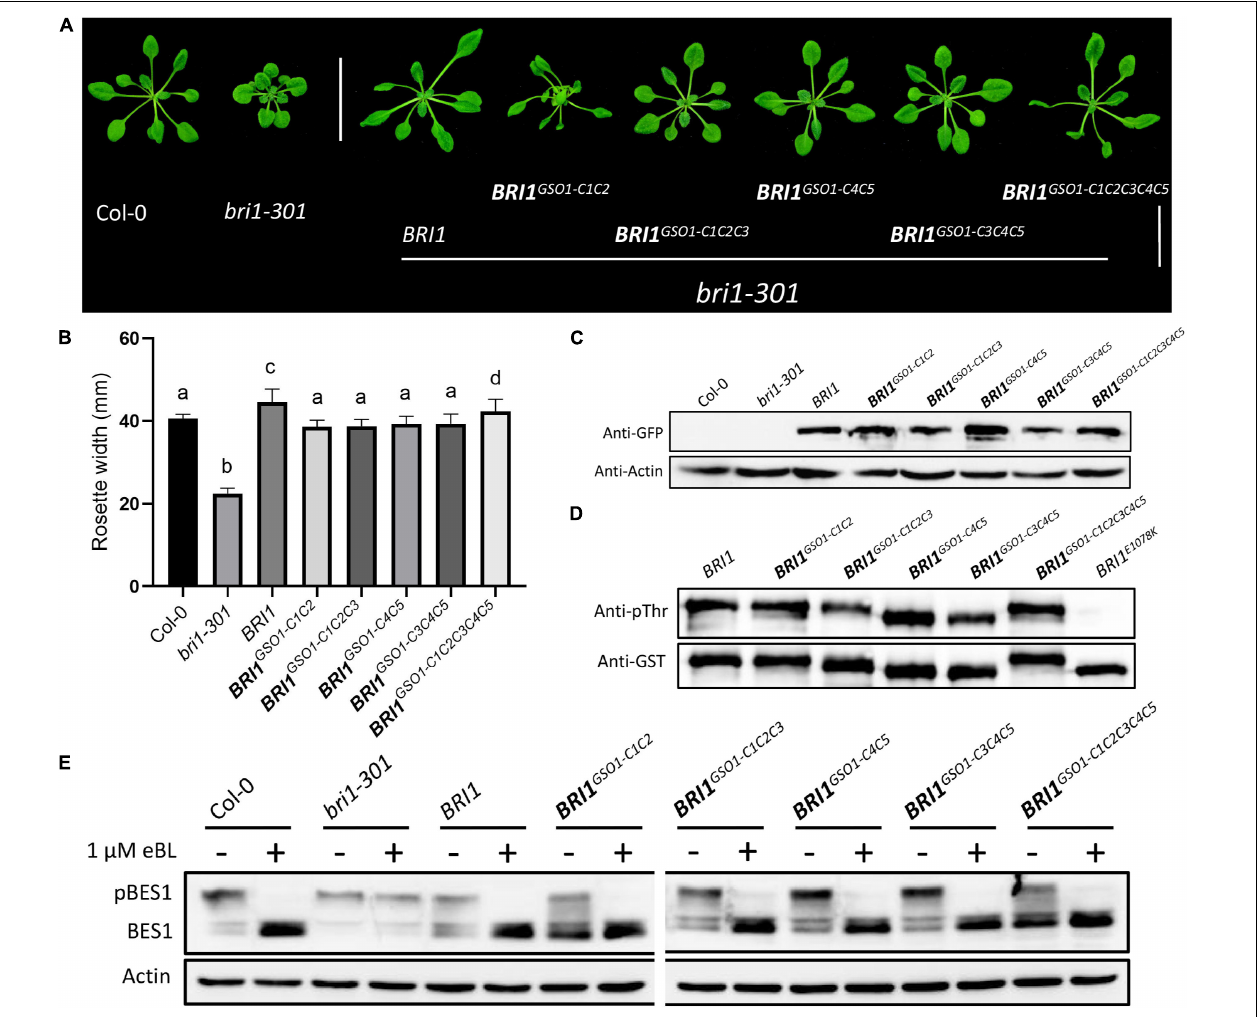
FIGURE 3 | Functional conservation in the C domains of BRI1. (A) phenotypes of 4-week-old transgenic lines representing the expression of functionally conserved chimeric receptors. Scale bar = 2.0cm. (B) Measurement of rosette width of transgenic lines ( n = 15), p < 0.0001, one-way ANOVA with a Tukey’s test. (C) Transgenic lines depicting protein expression profile. Anti-GFP was used to quantify the protein and actin served as a loading control. (D) In vitro kinase assay of GST-fused BRI1 and its chimeric proteins using an anti-pThr antibody. Anti-GST antibodies served as a loading control. Kinase-null mutant BRI1 E1078K was used as a negative control, and all the experiments were repeated independently three times with similar results. (E) BES1 dephosphorylation assay of BRI1 and its transgenic lines treated with or without eBL used in panel (A) . Actin used as a loading control.